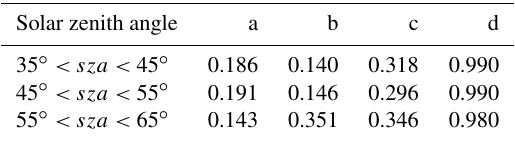
Table 2. Best fit parameters for the diffuse fractions ratio, fdif PAR as a function of the diffuse fraction of broadband radiation, f dif bb , for various solar zenith angles (Eq.